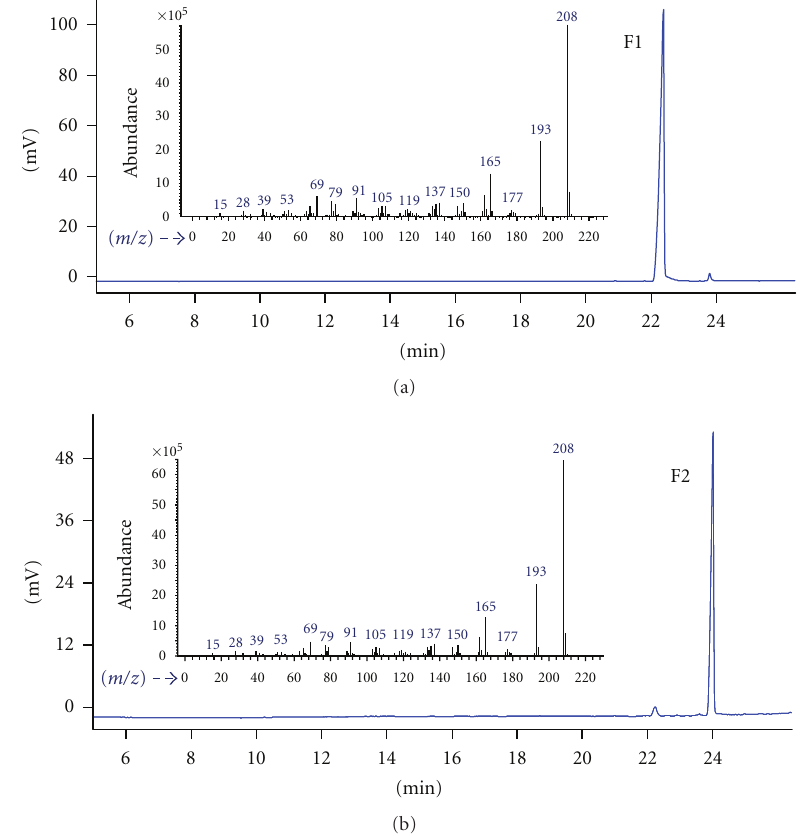
Figure 2: Capillary GC-FID chromatogram and MS spectra for the collected fractions (F1 and